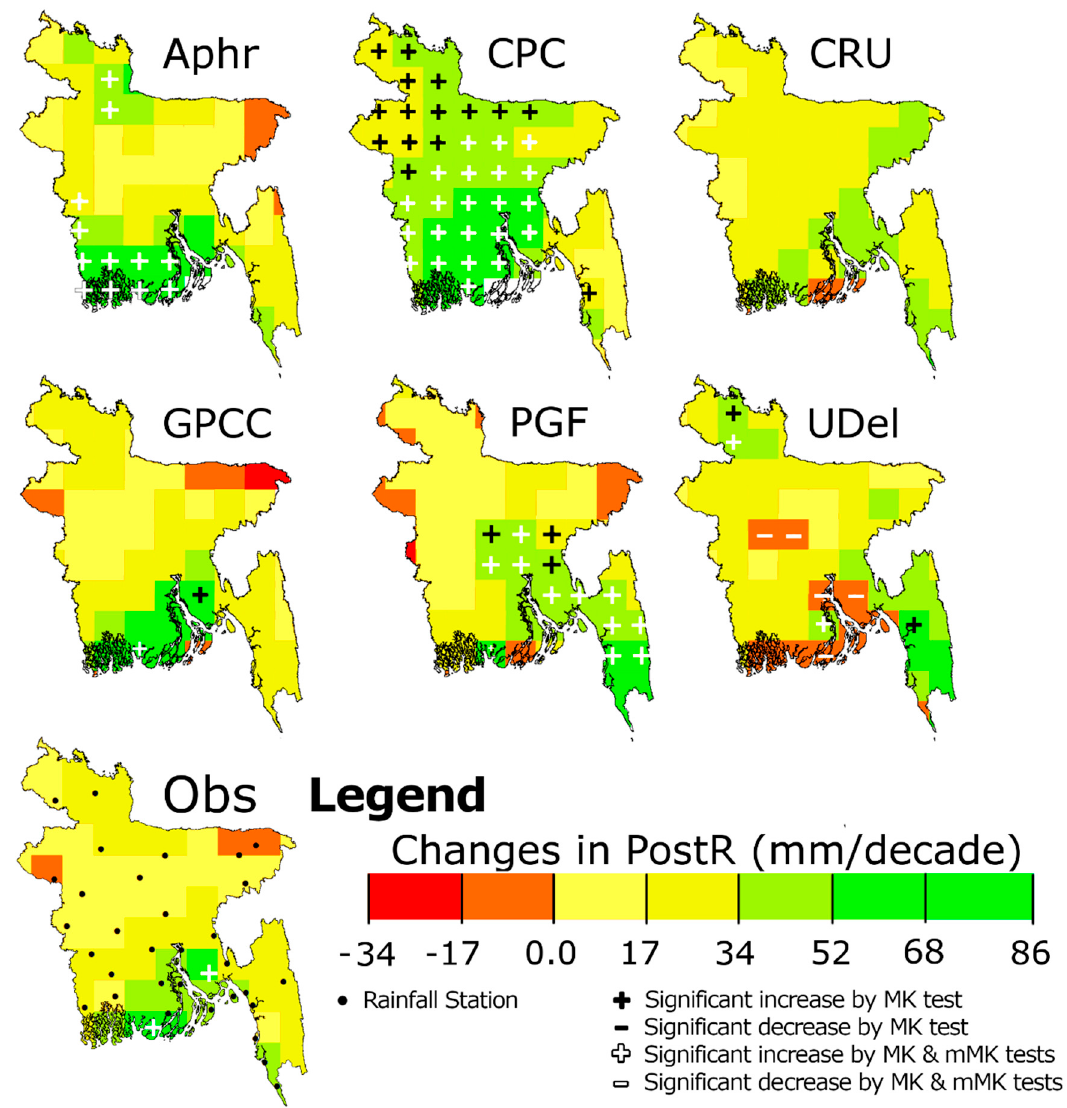
Figure 11. Trends in post-monsoon rainfall (PostR) in Bangladesh during 1979–2010.